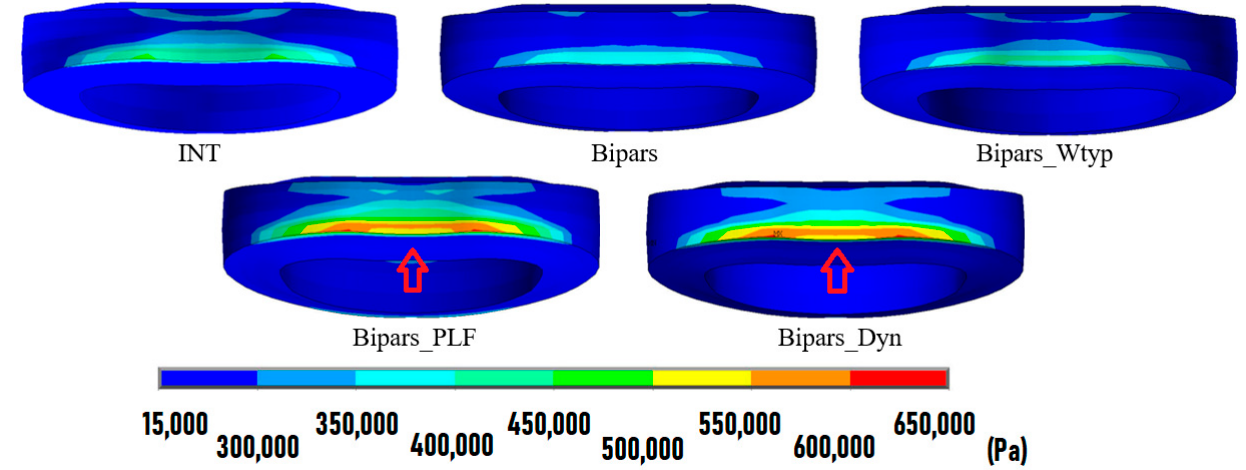
Figure 6. Stress distribution in all FE models in extension. High stress at screw heads was observed in the Bipars_PLF and Bipars_Wtyp models as indicated by the red arrows.